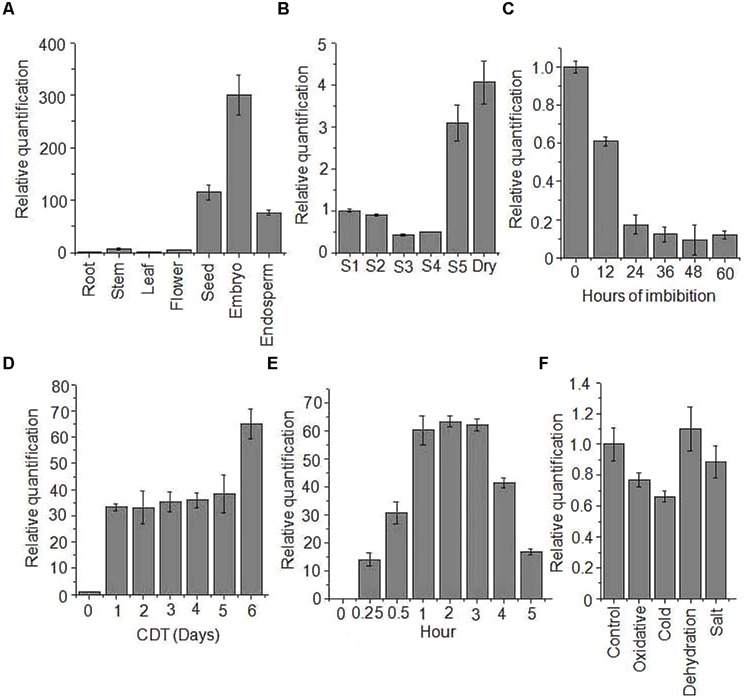
Expression profiling of OsHSP18.2. Transcript accumulation was analyzed by quantitative real time PCR (A) in different organs, (B) during seed development, (C) during seed germination, (D) under CDT, (E) under heat stress, and (F) under various abiotic stresses. Actin was used as an endogenous control. The relative expression value of each gene was normalized to an endogenous control and calculated using the ΔΔCT method (Applied Biosystems). Expression values are the mean ± SD of three independent biological measurements.